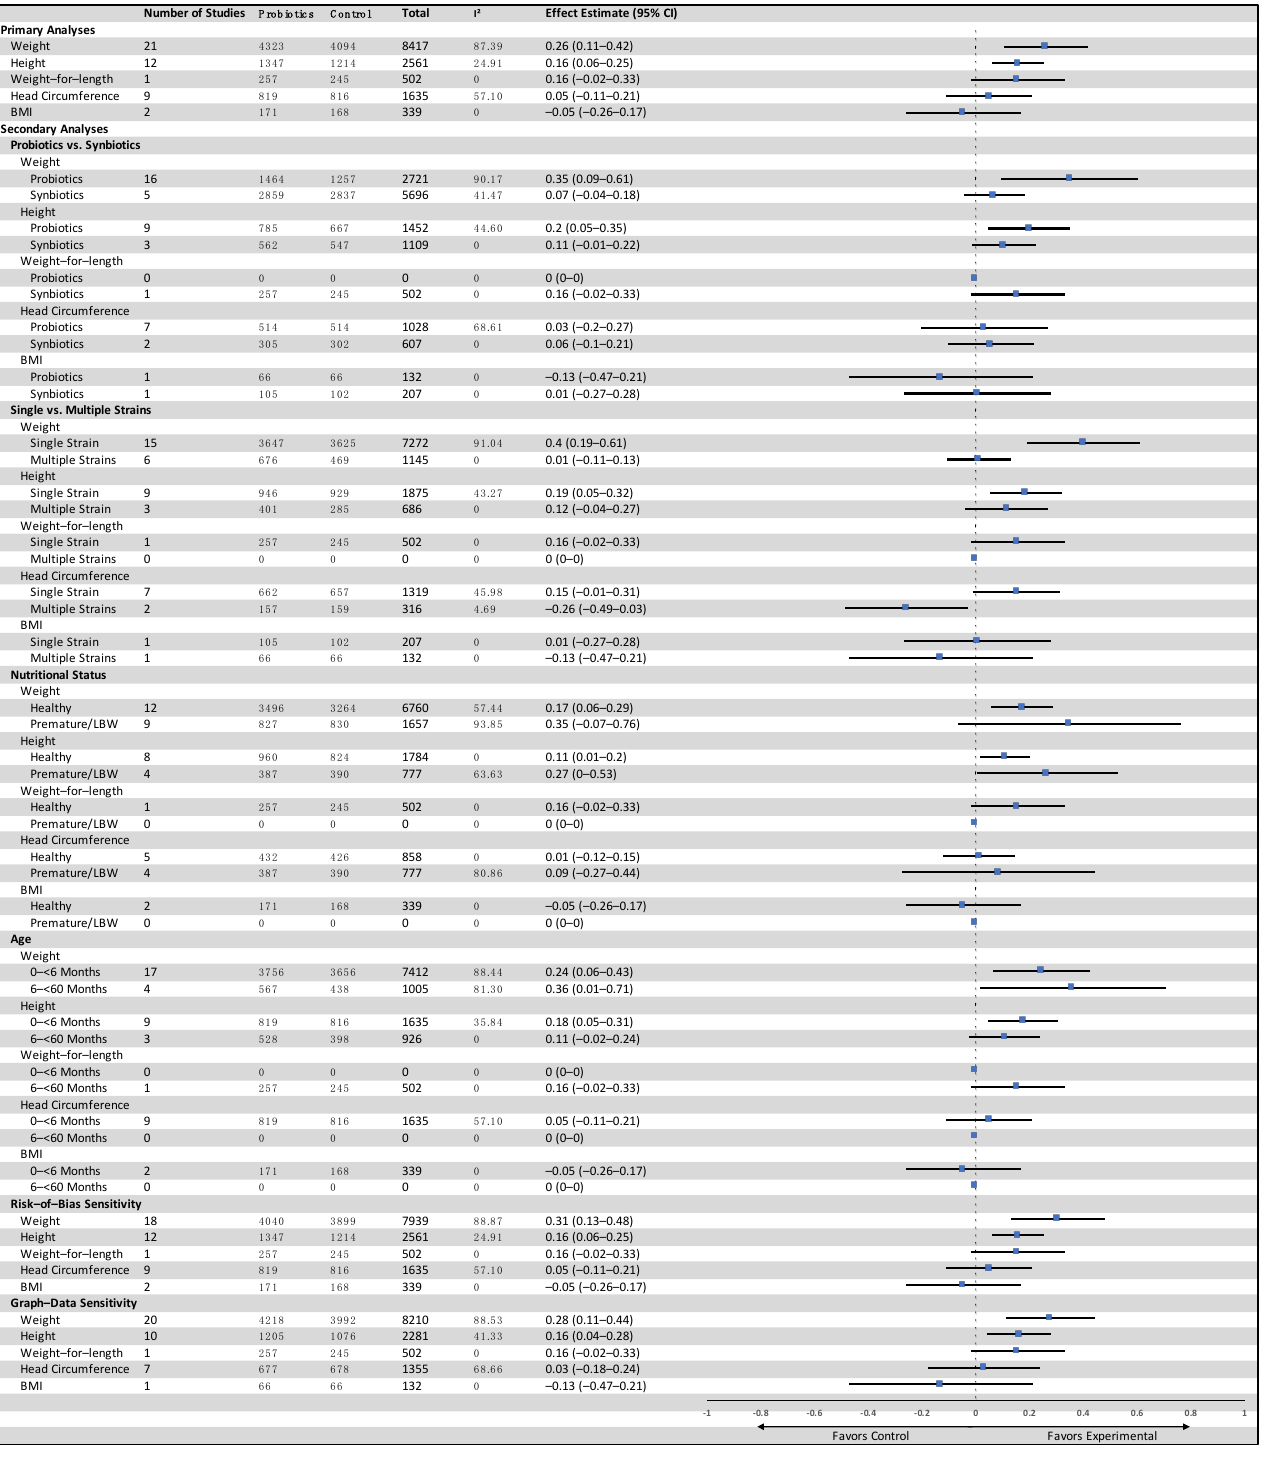
2561 participants (1347 probiotics, 1214 control) [21,27,33,36,39,50,70,83–85,91,92]. The re-